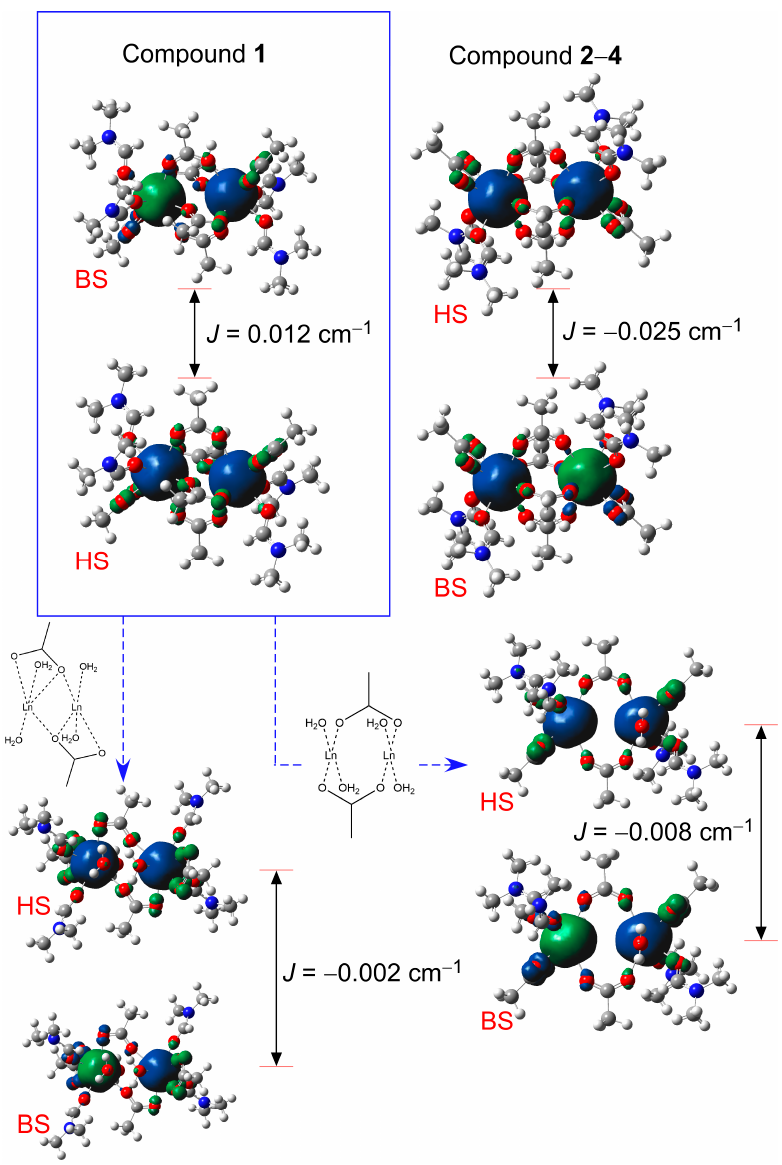
Figure 5. DFT-computed dimeric models cut from X-ray structures of compounds 1 (top left) and 2 – 4 (top right). The superexchange bridges conforming the paddle-wheel shaped entity of 1 are individually